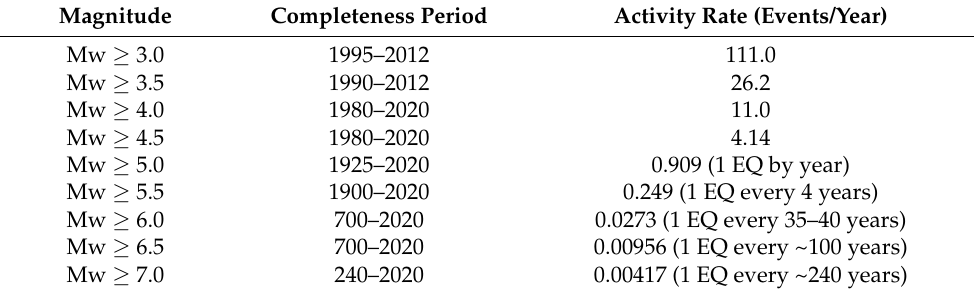
Table 1. Completeness periods and their corresponding activity rates for the current unified and declustered catalog. See Figure 2. Magnitude Completeness Period Activity Rate